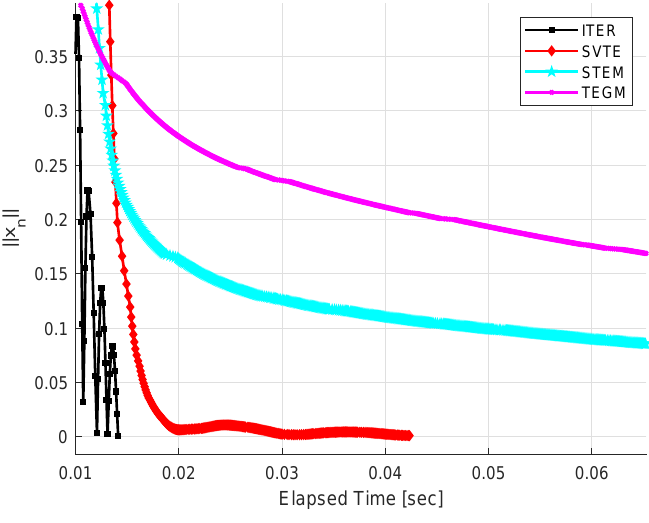
Figure 1. Example 1, m = 10.